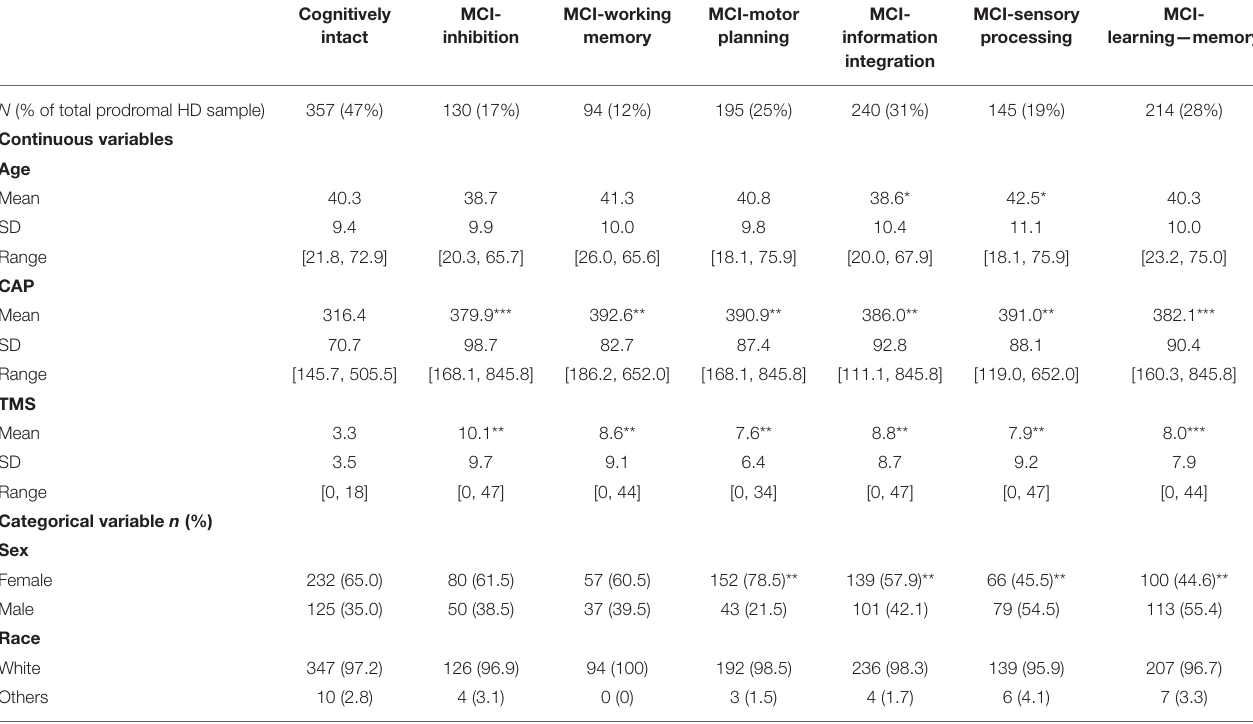
TABLE 2 | Summary statistics of clinical and demographic variables among MCI groups at study entry (baseline).